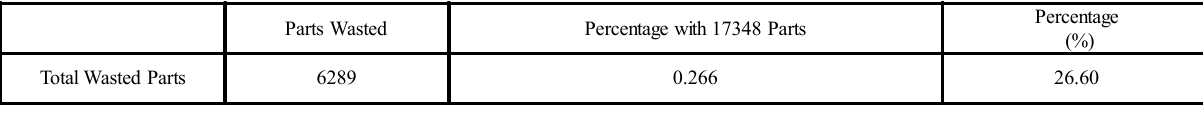
TABLE 6. OVERALL WASTES PARTS PER